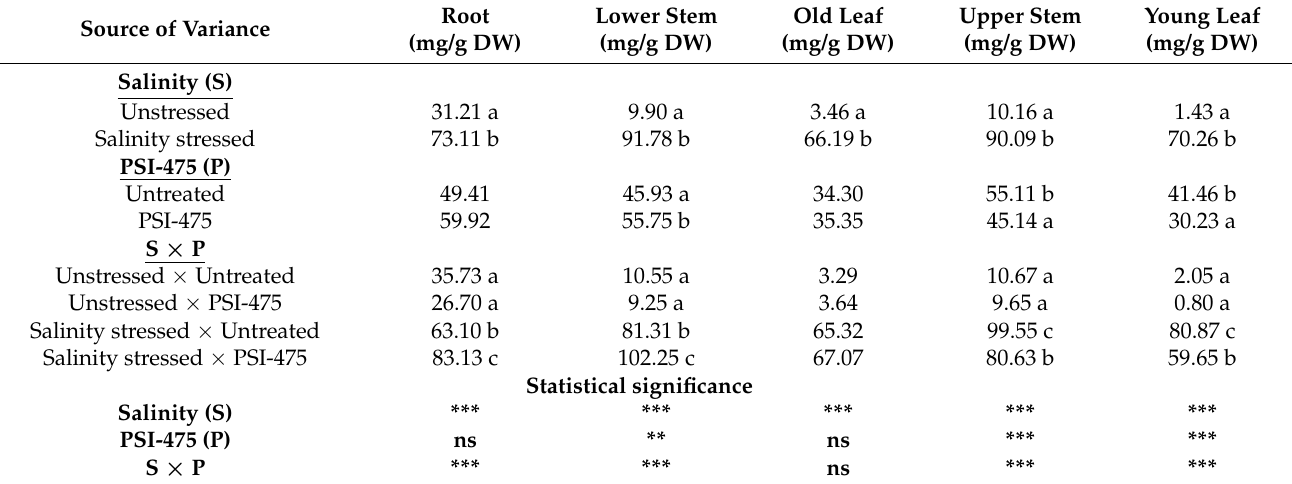
Table 2. Effect of salinity stress and PSI-475 on sodium (Na + ) content in different tomato plant